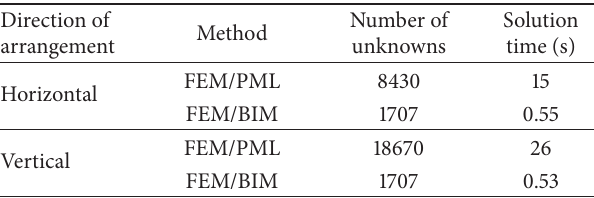
Table 2: Comparisons of solution time and number of unknowns for different